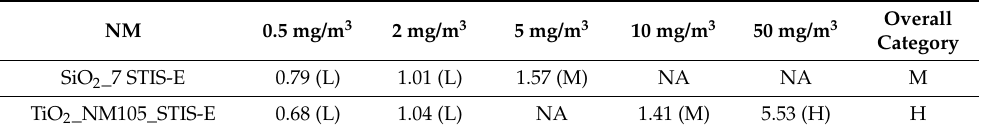
Table 4. Protein carbonylation (values are fold changes relative to control) in rat lung following NM